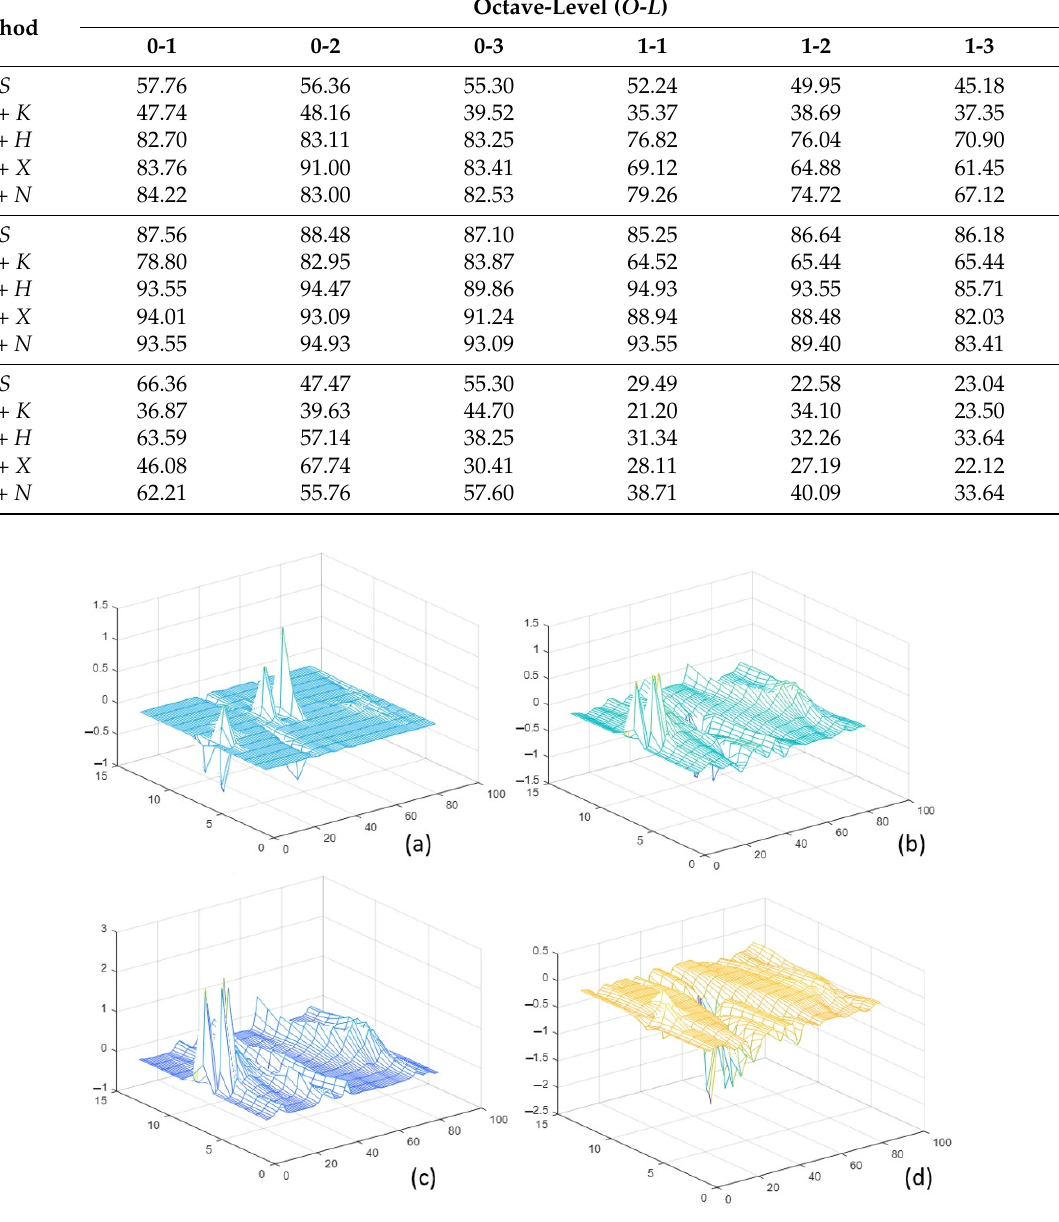
Figure 6. Combination results of ( a ) SS + K , ( b ) SS + H , ( c ) SS + X , and ( d ) SS + N with O = 1 and L = 1 for an eyebrow image.